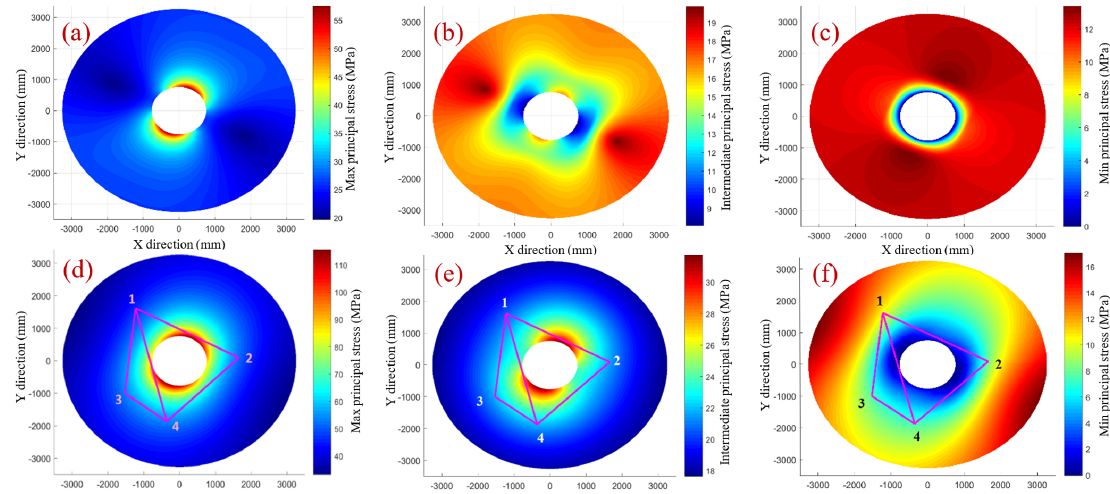
Figure 9. Ray paths plotted over the calculated principal stress components around the ONK-EH3. The first row) after excavation and before heating; the second row) at the end of 12 weeks of heating, the ray paths are over plotted.